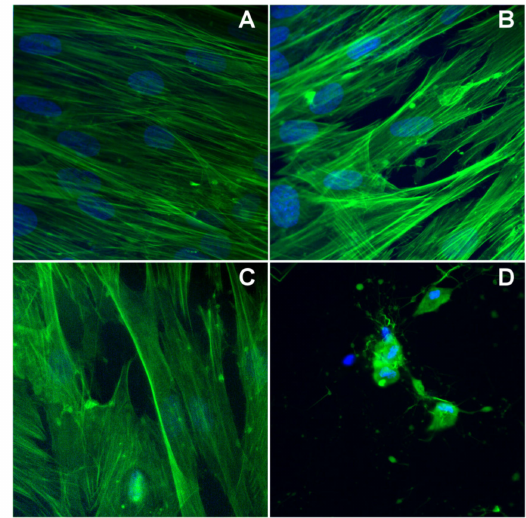
Figure 9. The cytoskeleton alteration for BJ cells: ( A ) control cells, ( B ) cells treated with pmtp, ( C ) cells treated with ( 1 ), ( D ) cells treated with ( 2